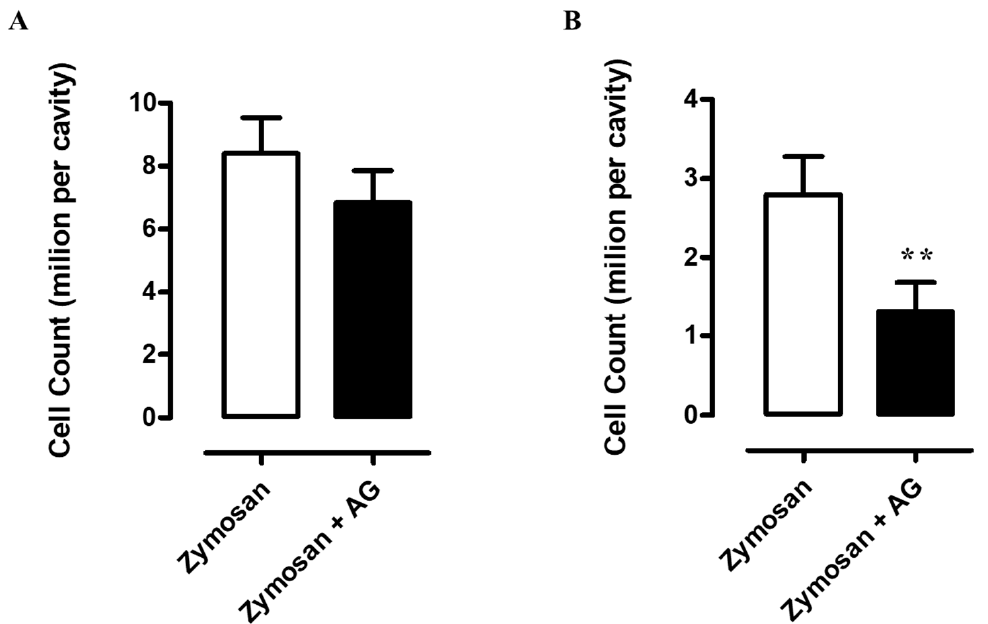
Figure 5. ( A ) Cell infiltration into mouse peritoneal cavity of mice that have received an intraperitoneal (i.p.) injection of zymosan (500 mg/kg) or zymosan + AG (150 mg/kg) at 4 and ( B ) 24 h. Bars represent group mean values ± Standard Error of the Mean (S.E.M) of three separate experiments with n = 7 mice. ** p < 0.01 vs. zymosan-treated mice.